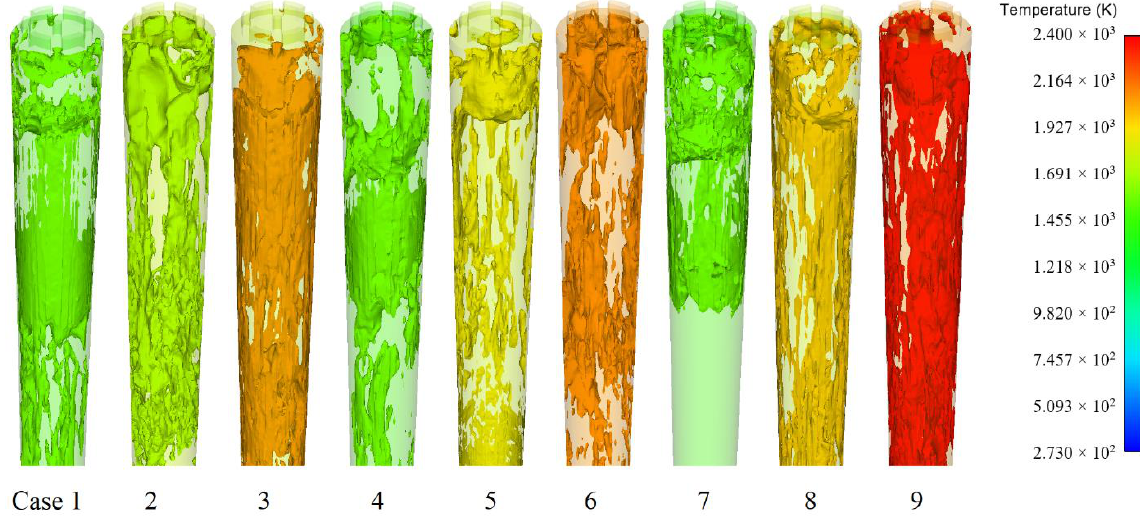
Figure 8. Syngas temperature for various cases at the exit of the gasifier.